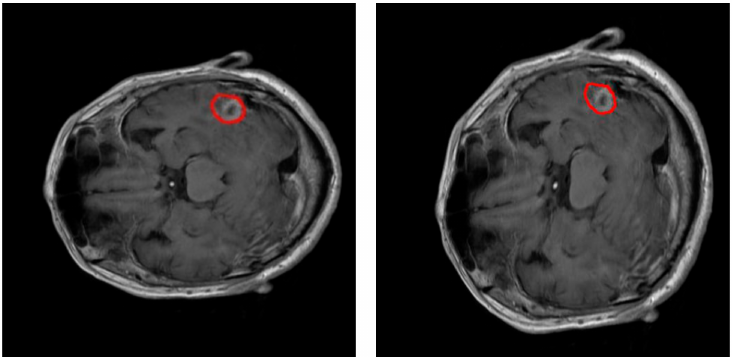
Figure 3. Example of elastic transformation used in the data augmentation. Left: original slice. Right: image transformed. In both images, the edges of the tumor have been highlighted in